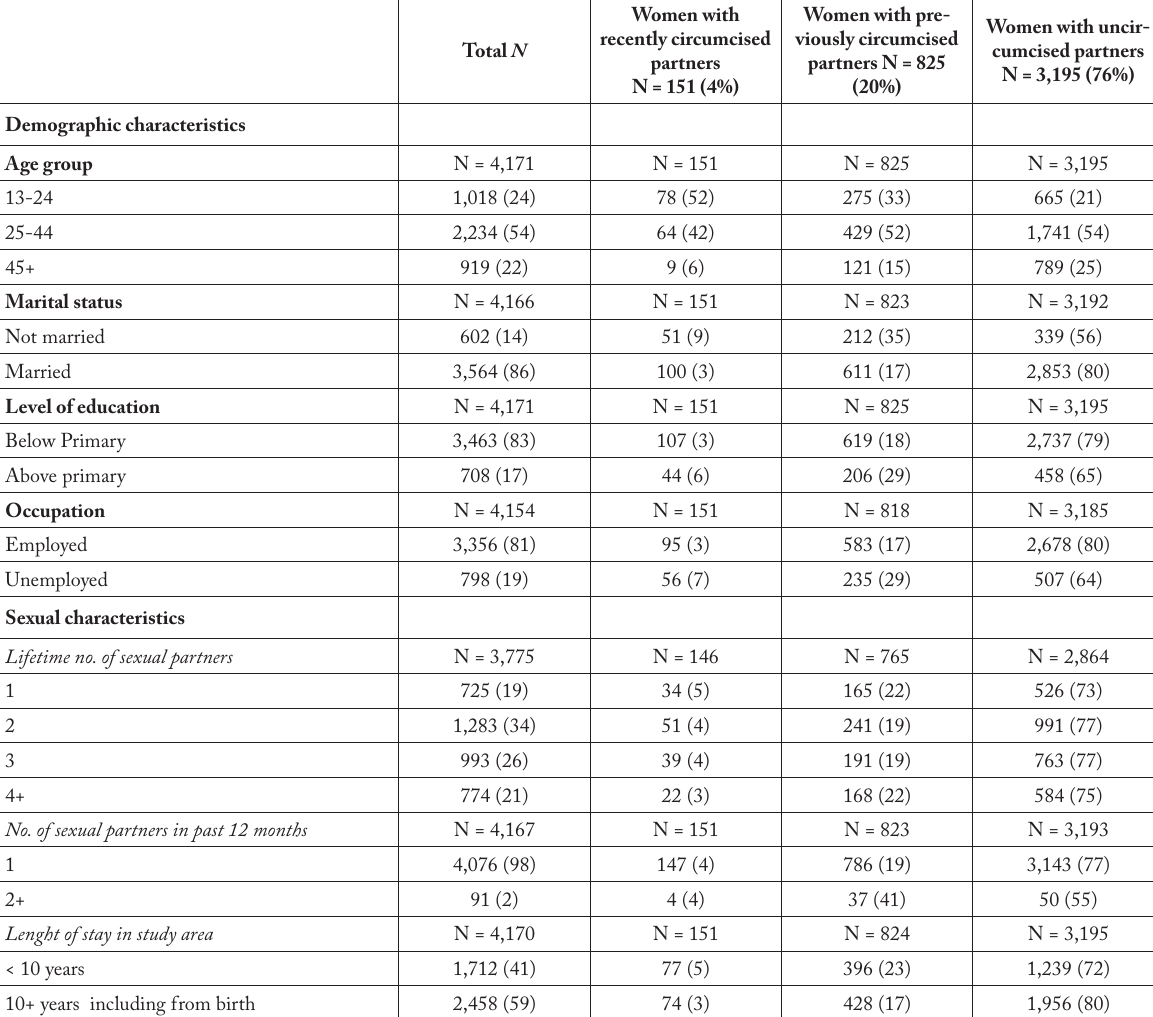
Table 3. Demographic and Sexual Characteristics of Female Respondents in Gem, Siaya County, Western Kenya, 2012-2014 ( n =